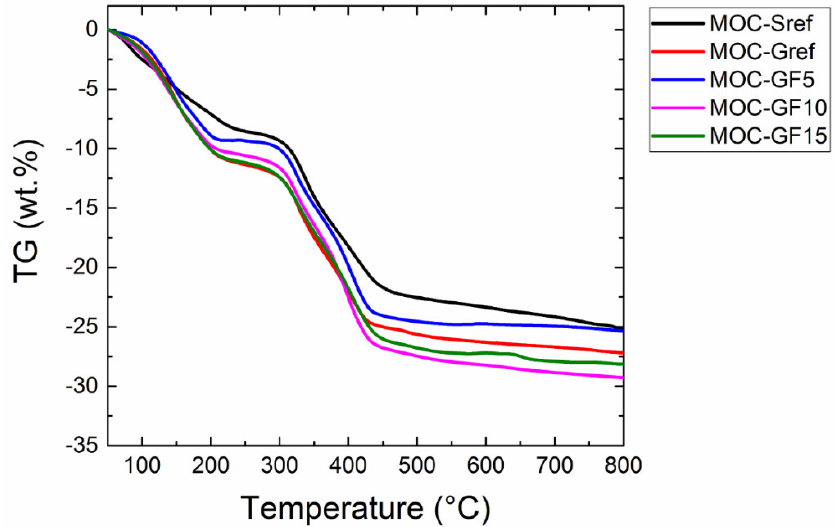
Figure 8. TG curves of prepared composites measured in dynamic air atmosphere.